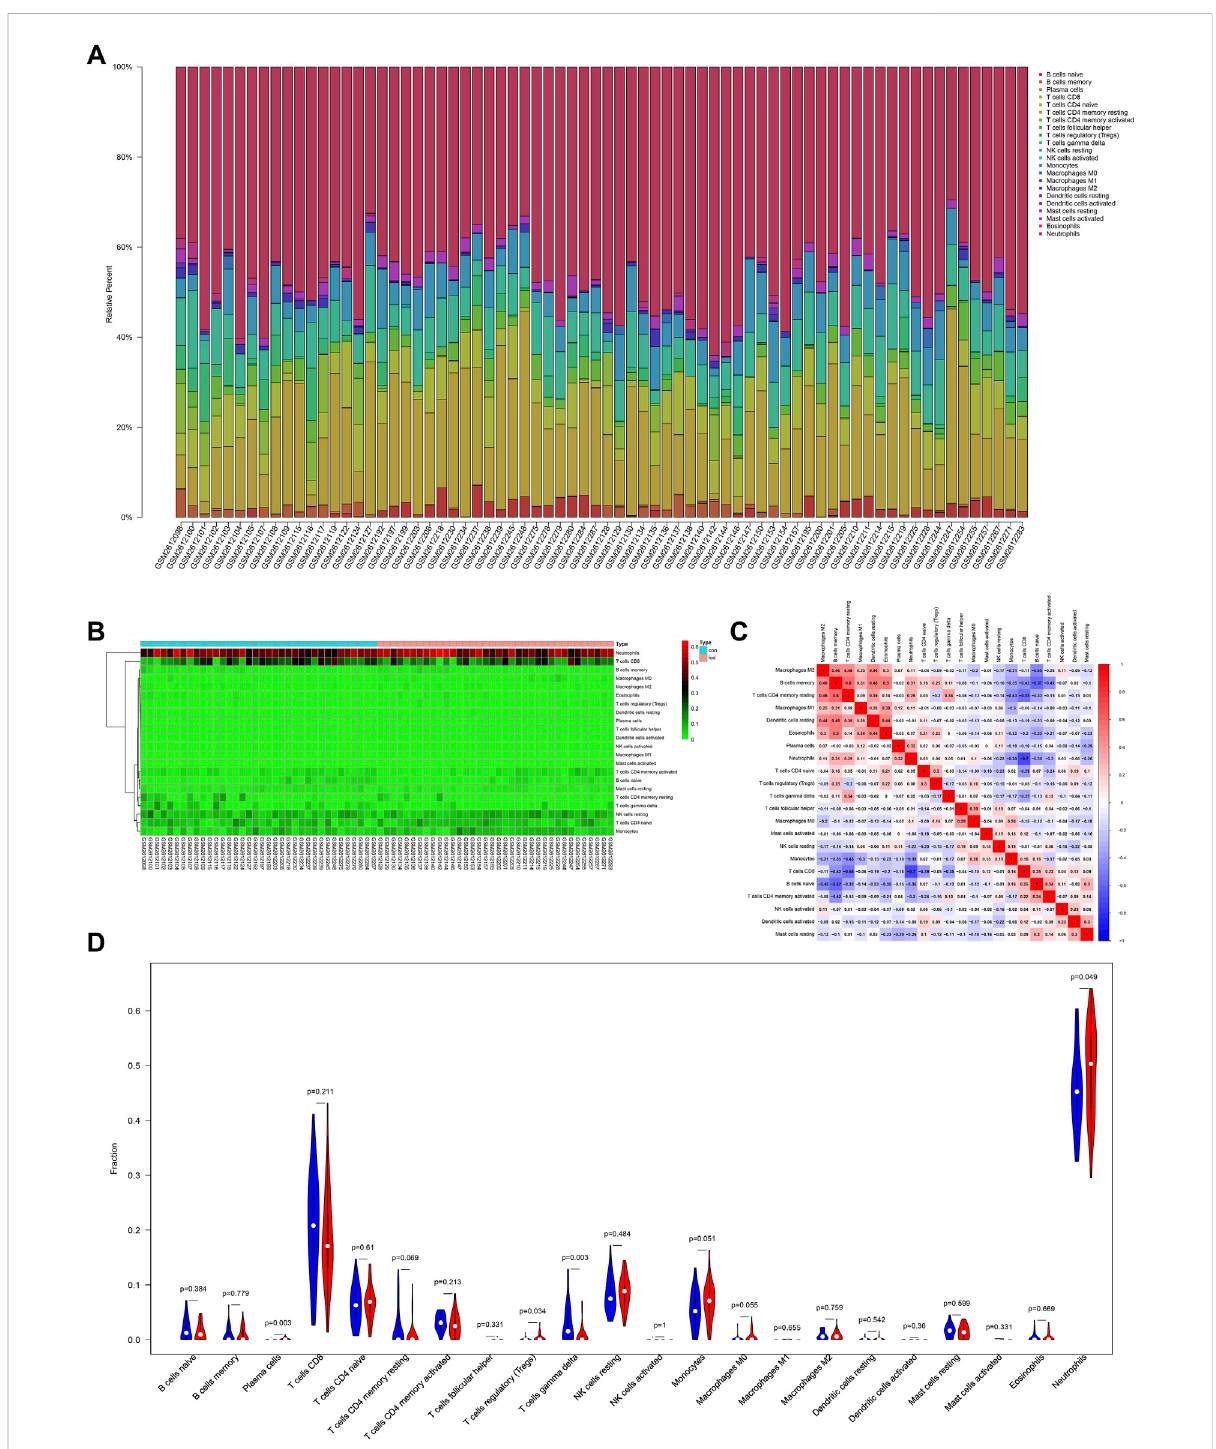
FIGURE 5 Immune in fi ltration situation in peripheral blood samples from healthy subjects and LOD patients. (A) Histogram of percentage distribution of 22 immune cell subtypes. (B) Heatmap of percentage distribution of 22 immune cell subtypes. (C) Heatmap of 22 immune cells in both samples. Positive and negative correlations are shown in red and blue, respectively. (D) Violin plot of differences in immune cell in fi ltration between healthy subjects and LOD patients. Blue, healthy subjects; red, LOD